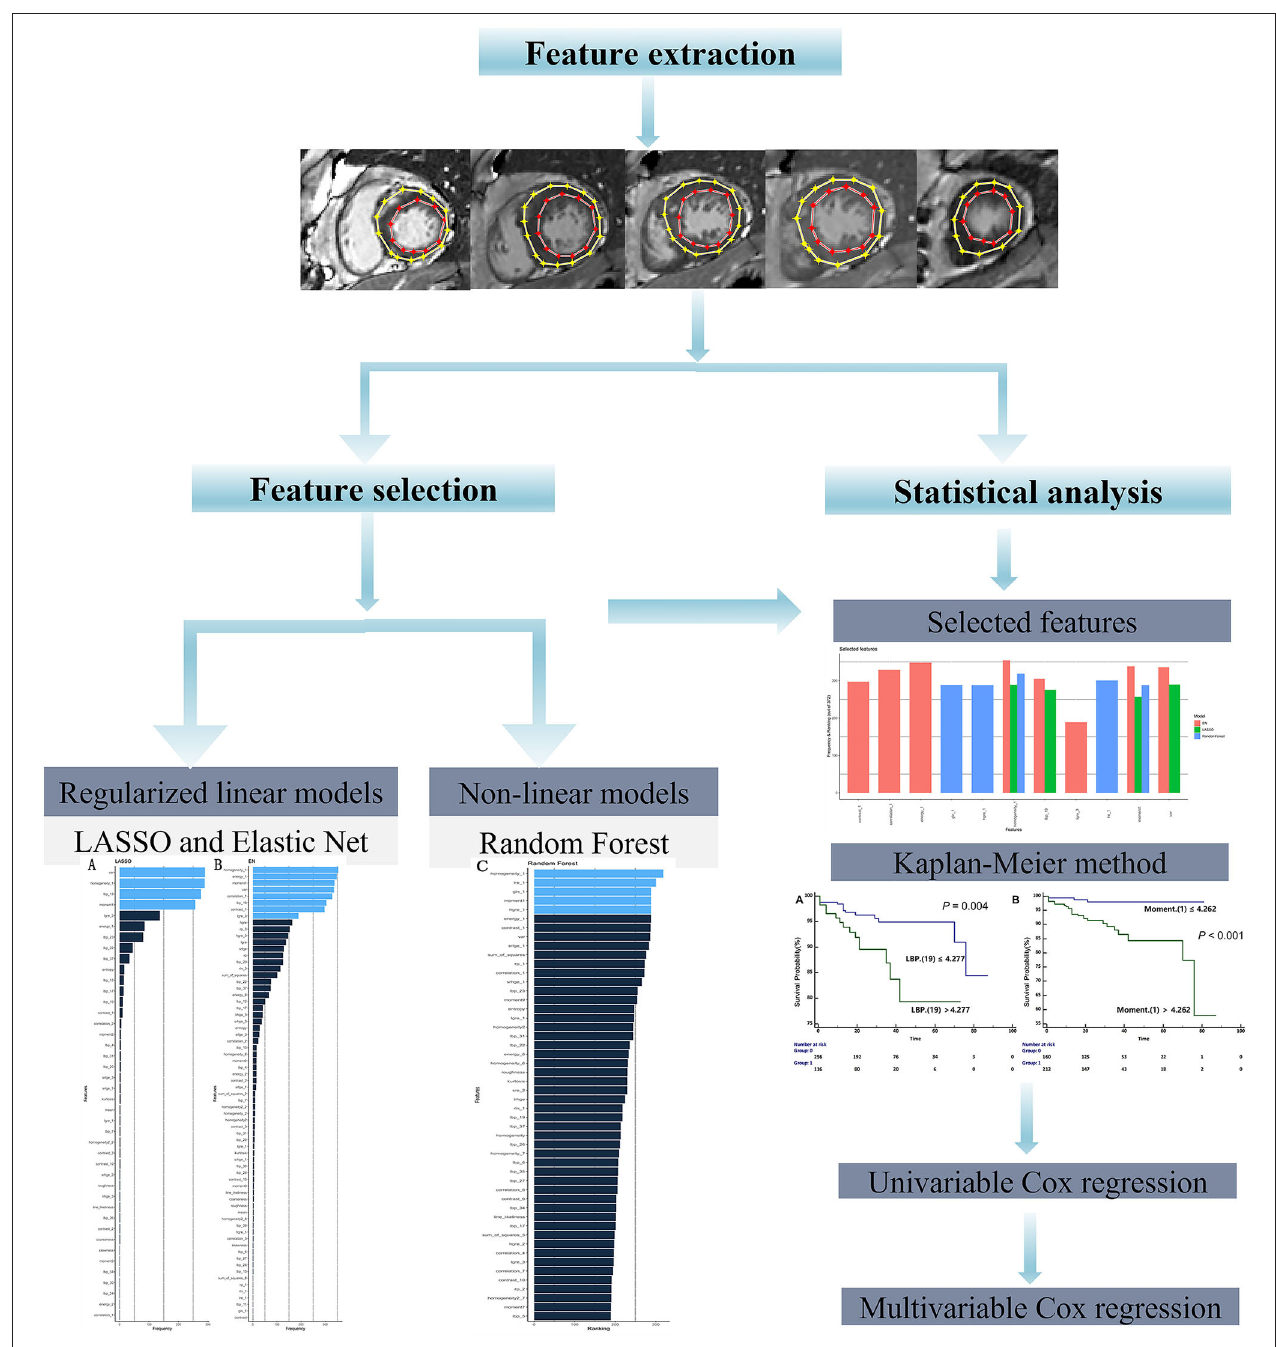
FIGURE 1 | Radiomic